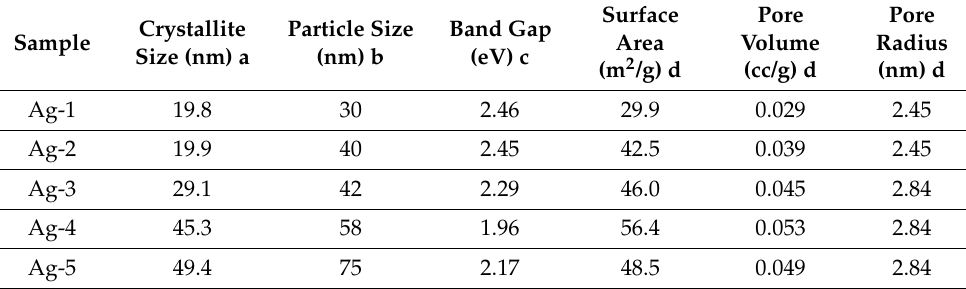
Table 1. Data obtained from XRD, SEM, DR UV- vis , and N 2 -physisorption